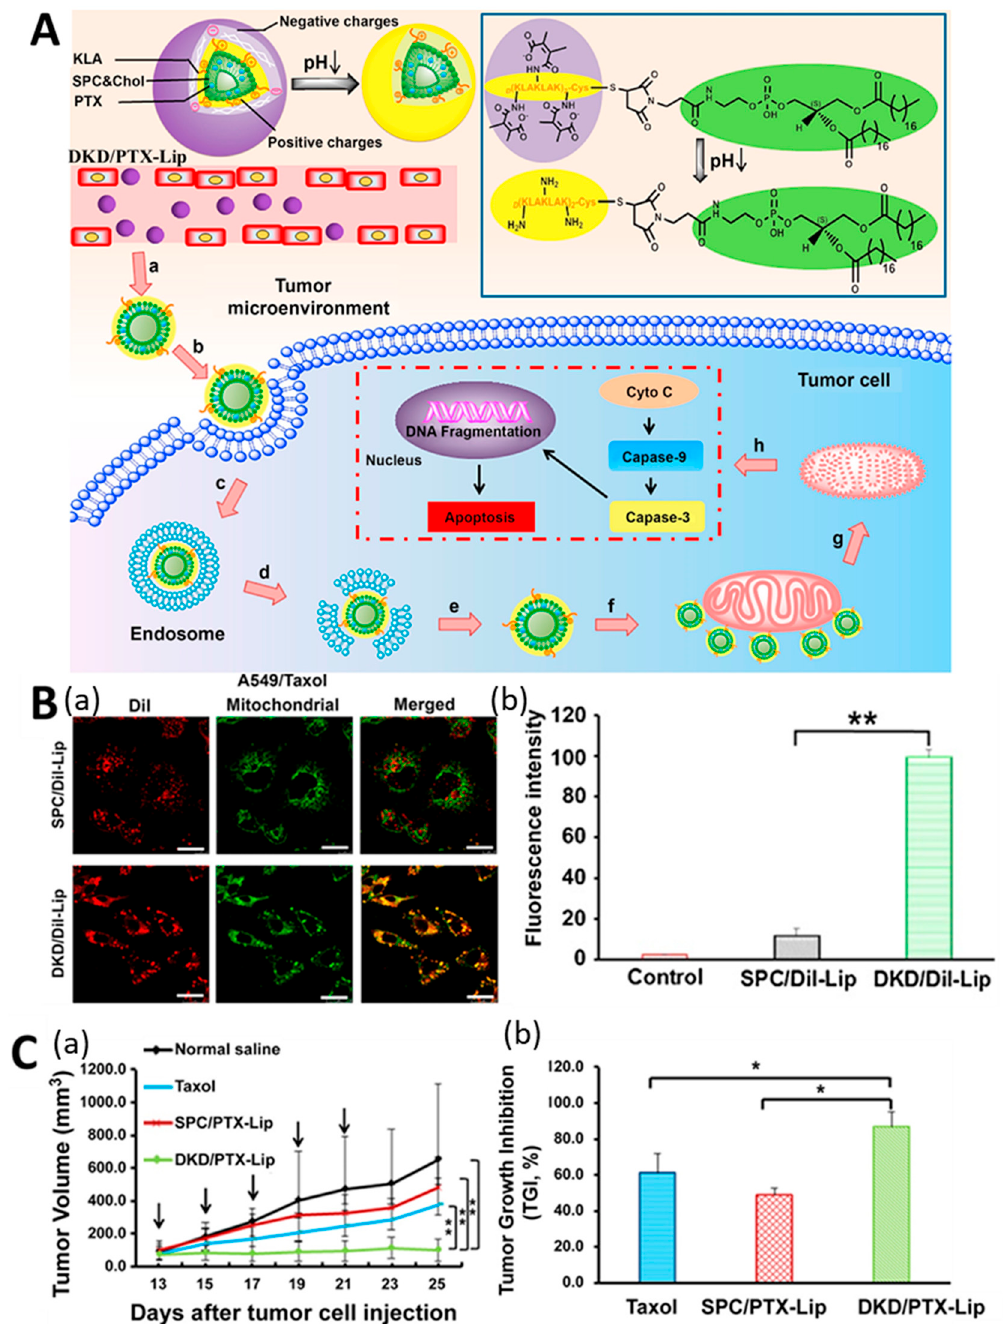
Figure 5. Mitochondrial targeted liposomal delivery of paclitaxel (PTX) to drug-resistant lung cancer cells. ( A ) Illustration of pH-responsive dual-functional liposomes (DKD/PTX-Lip) to the tumor microenvironment and mitochondrial-targeting PTX delivery. ( a ) pH-response of DKD to mildly acidic tumor microenvironment for surface charge conversion, ( b ) the positive charge of liposome improved cellular uptake, ( c ) internalization of liposomes into tumor cells, ( d ) endosomal escape, ( e ) cytoplasmic release, ( f ) binding to mitochondria, ( g ) mitochondria damage, and ( h ) promotion of cell death via mitochondria apoptotic pathway. ( B ) Mitochondrial localization of 1,1’-dioctadecyl- 3,3,3’,3’-tetramethylindocarbocyanine (Dil)-loaded DKD-Lip (DKD/Dil-Lip) in taxol-resistant lung cancer cells (A549/Taxol). ( a ) Confocal images showing mitochondrial accumulations of DKD/Dil-Lip (red) and control preparations. Control liposomes SPC/Dil-Lip were prepared by loading Dil into the traditional liposomes. A549/Taxol cells were incubated with the liposomes for 12 h and then stained with Mitotracker Green FM (green). Yellow spots in the merged pictures indicate the co-localization